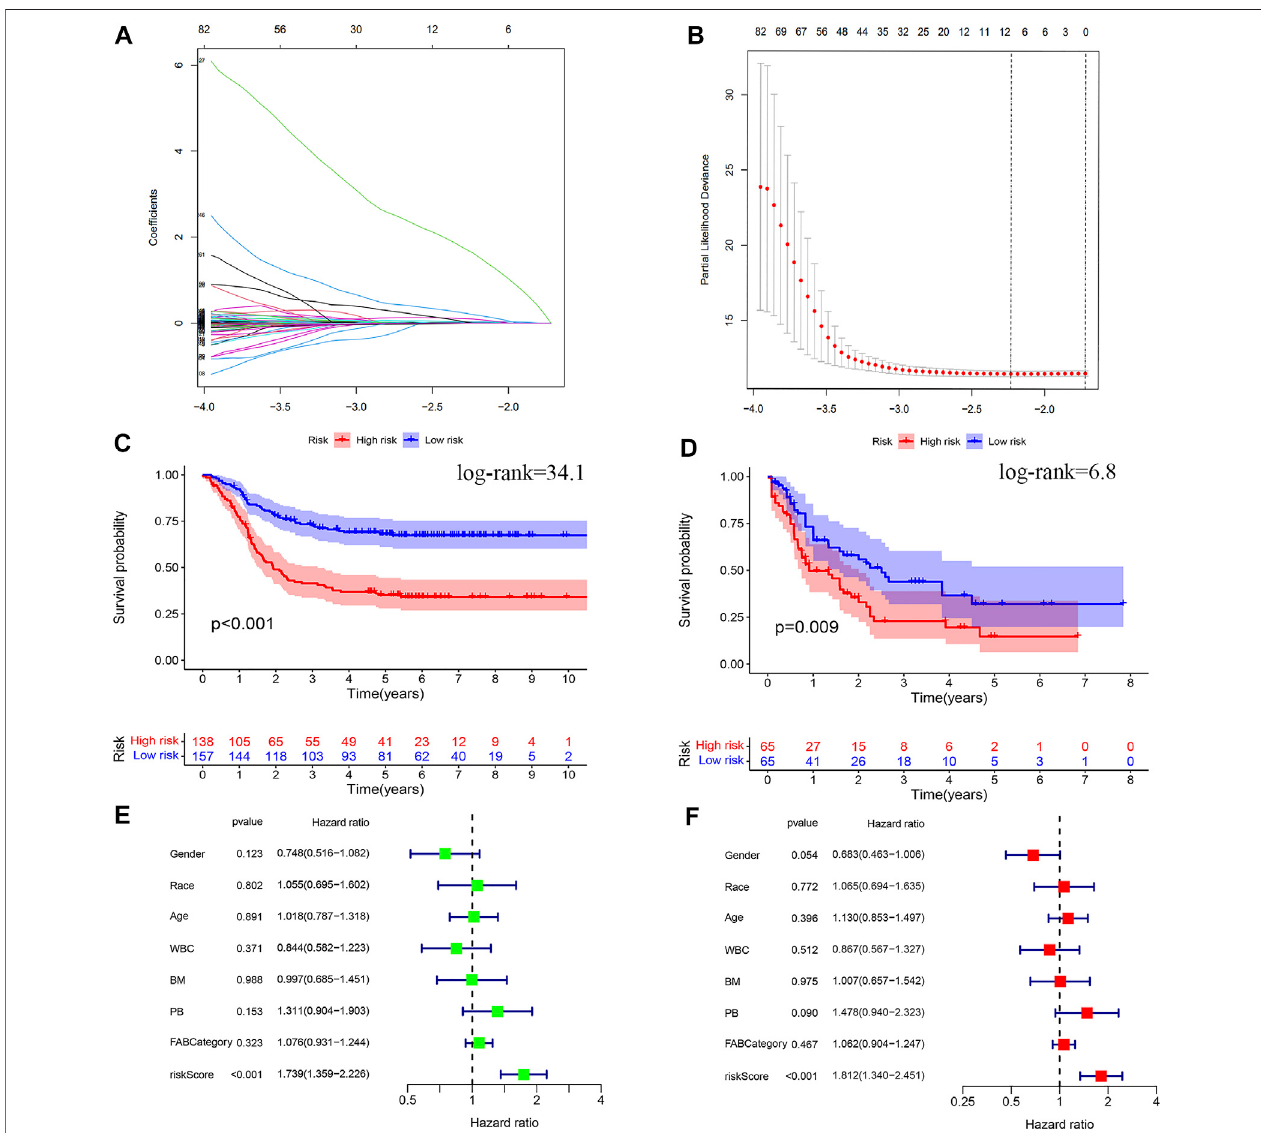
FIGURE 5 | Construction of the risk model of m6A-related prognostic lncRNAs in AML. (A,B) LASSO regression was performed, calculating the minimum criteria. (C) Kaplan – Meier curve showed that the high-risk group had a more inferior OS than the low-risk group in the TARGET database. (D) Kaplan – Meier curve showed that the high-risk group had a more inferior OS than the low-risk group in the TCGA database. (E) Results of the univariate Cox regression analysis incorporating clinical factors. (F) Results of the multivariate Cox regression analysis incorporating clinical